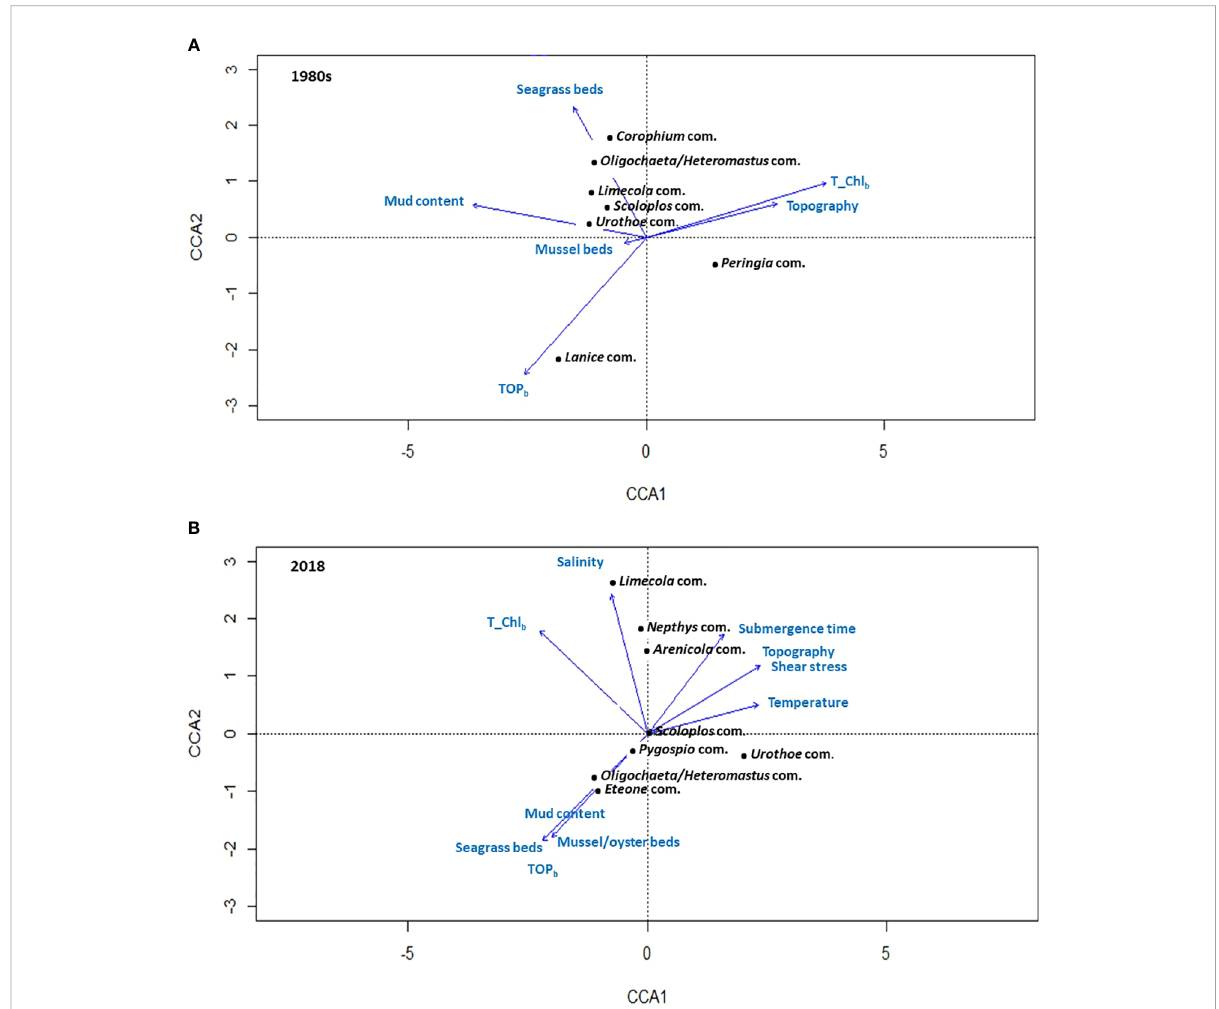
FIGURE 9 Canonical Correspondence Analysis (CCA) biplots; (A) for the 1980s, showing the environmental parameters having the highest correlation with the variation in the seven separated macrofauna communities; (B) for 2018, showing the environmental parameters having the highest correlation with the variation in the eight separated macrofauna